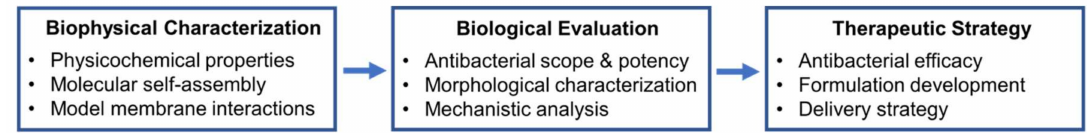
Figure 8. Overview of experimental strategy to characterize antimicrobial lipids based on integrating biophysical and biological